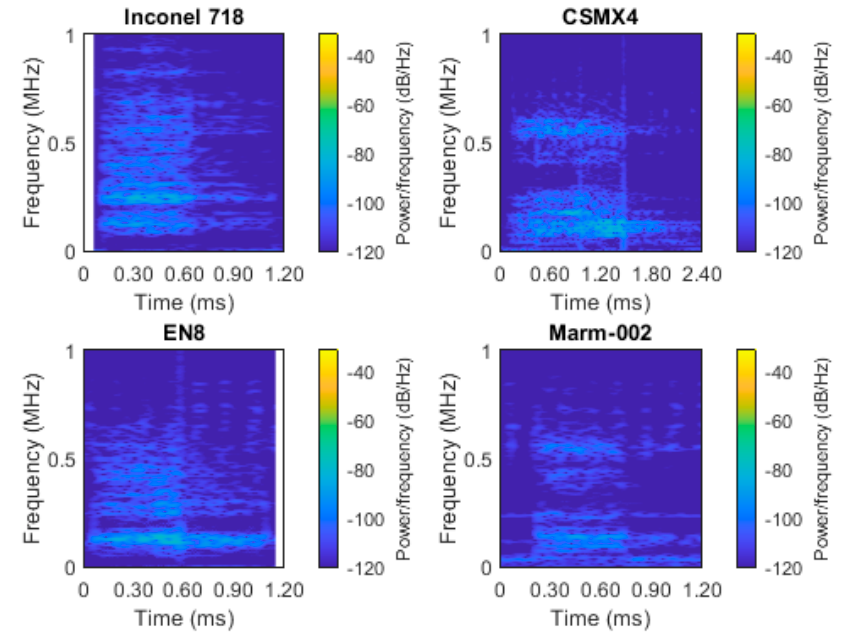
Figure 21. AE STFT for SG tests for Inconel 718, CSMX4, EN8, and MARM-002.